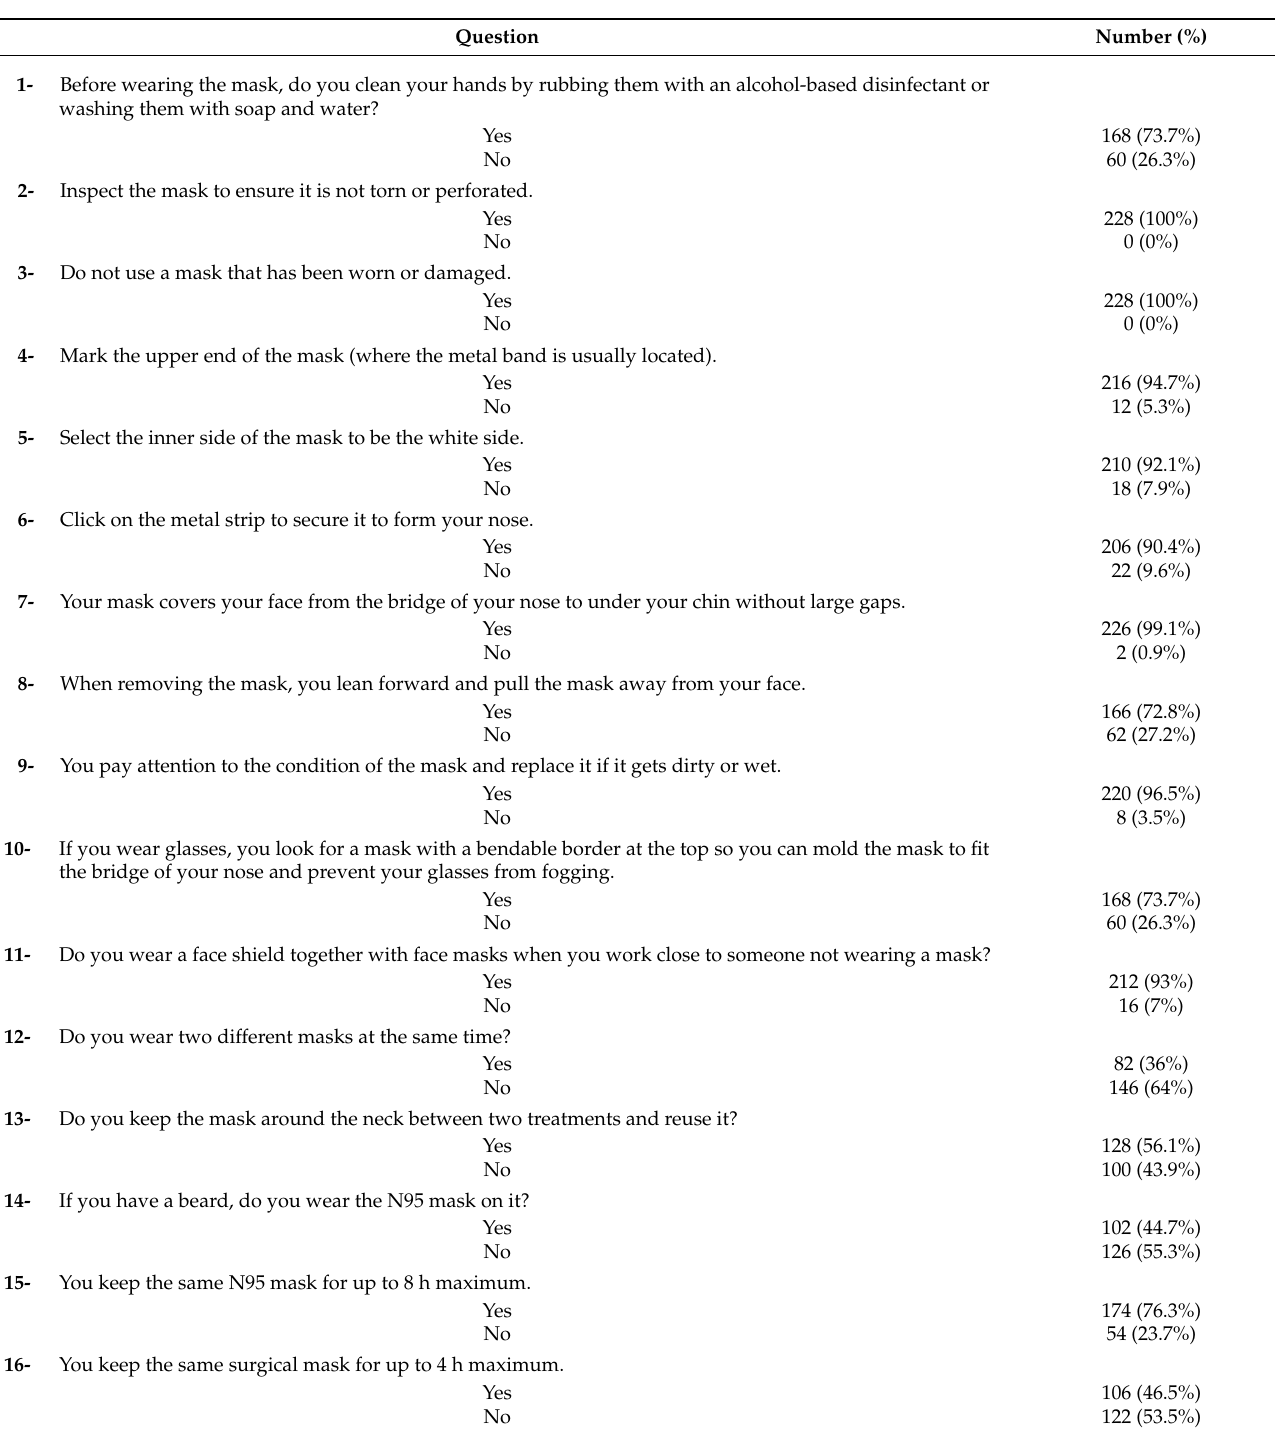
Table 5. Experiences of using face